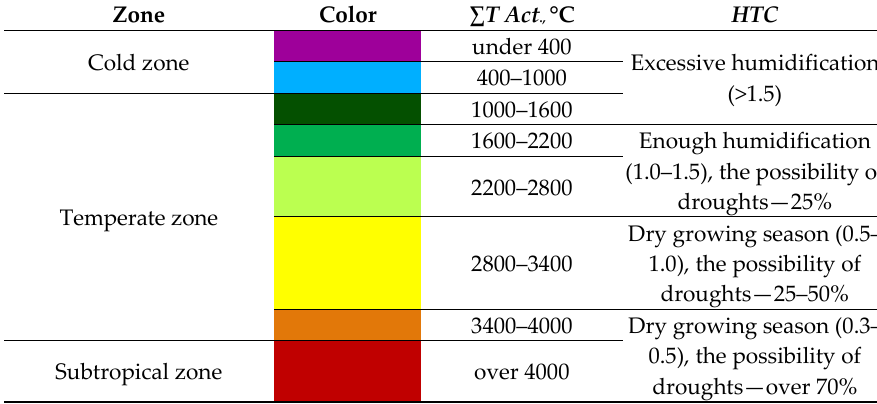
Figure 4. Borders of agro-climatic zones in the European territory of Russia: ( a ) in 1964; ( b ) currently. Thus, in the Central region of the Non-Chernozem zone, local climate warming led to a shift in the isotherm of the sum of active temperatures by 150–200 km towards higher latitudes: if in 1981, the isotherm went through the northern part of Bryansk and Oryol Oblast, including a small part of Kaluga and Ryazan Oblast, currently it goes through the northern part of Moscow Oblast, partially including the territory of Tver Oblast, including Vladimir Oblast and the southern part of Kostroma Oblast. by year (Figure 5).